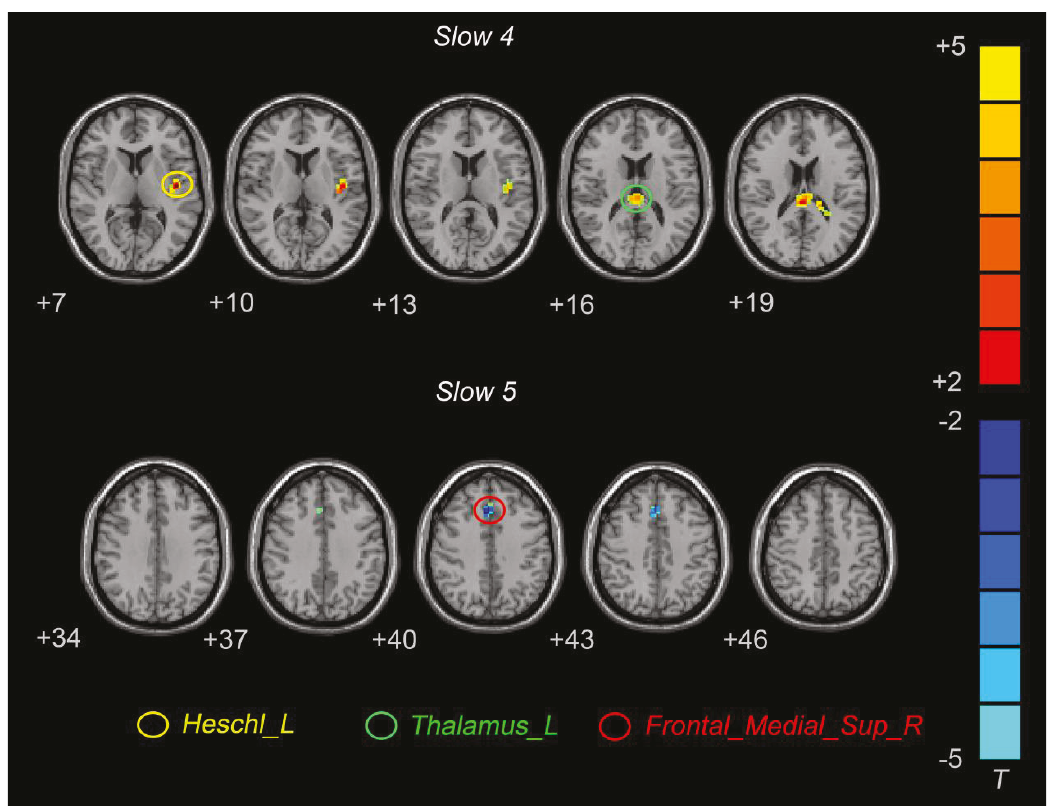
Figure 2: Brain regions showing di ff erent CReHo values between the D-MCI and nD-MCI groups in the slow-4 and slow-5 frequency bands ( contrast = D -MCI −